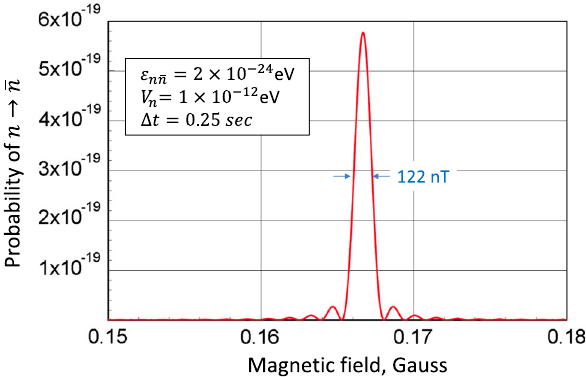
Fig. 3 Variation of the external magnetric field that would compensate for the effect of the B − L potential V n = 10 − 12 eV for flight time 0.25s ent masses of the neutron and antineutron, m n − m ˜ n (cid:17)=